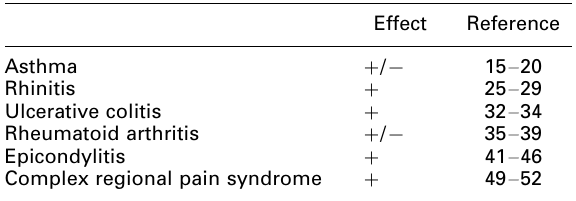
Table 1. Summarised effects of acupuncture in inflammatory